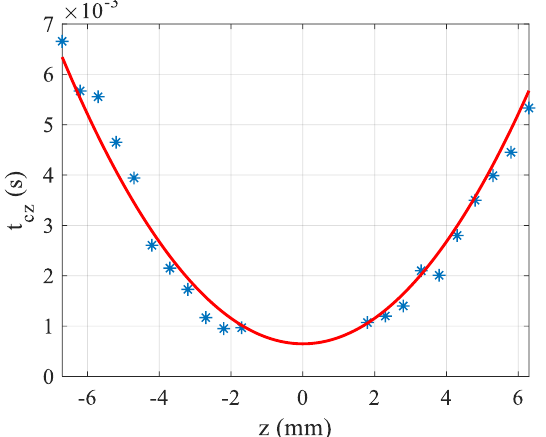
Figure 5. Characteristic time of the solution versus the position of the sample. The data are in blue stars and the solid line is the fitting.